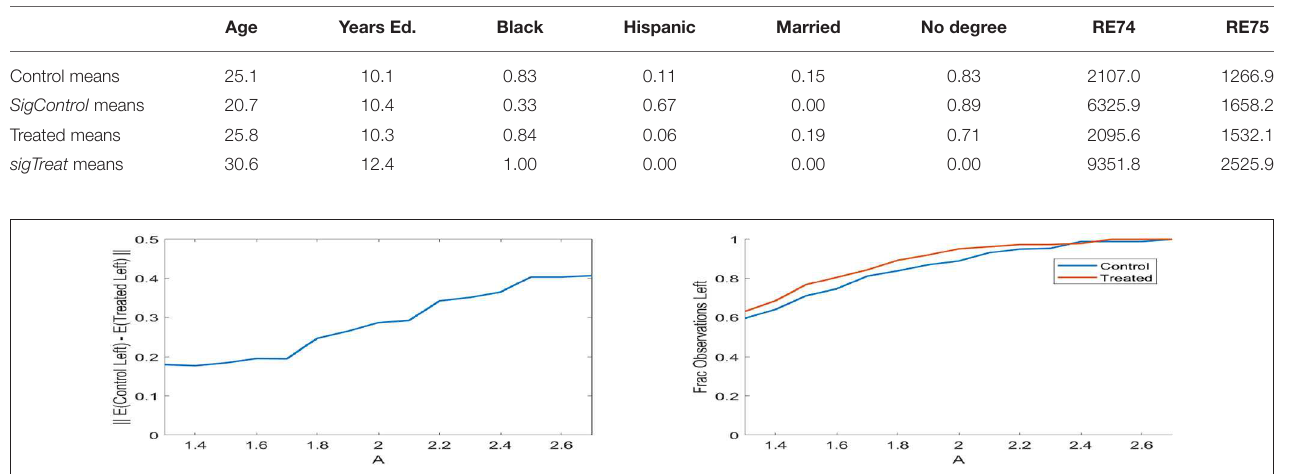
1 for varying A . (Right) Fraction of = 1 for varying A . For both plots, A closer to 1 imples we are liberal =